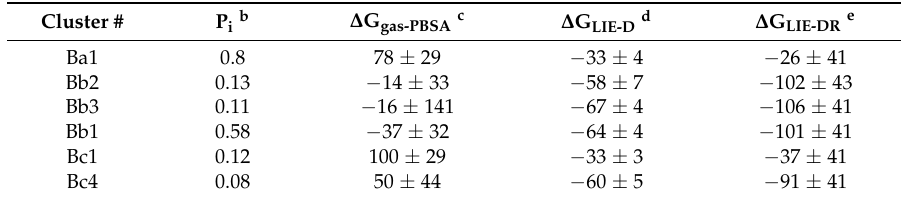
Table 2. A β 42 -SGB1 energy analysis: A β -SGB1 (SGB1 = PP) energy analysis (kJ/mol). The clusters are listed by the hierarchy of their appearance in the trajectory a